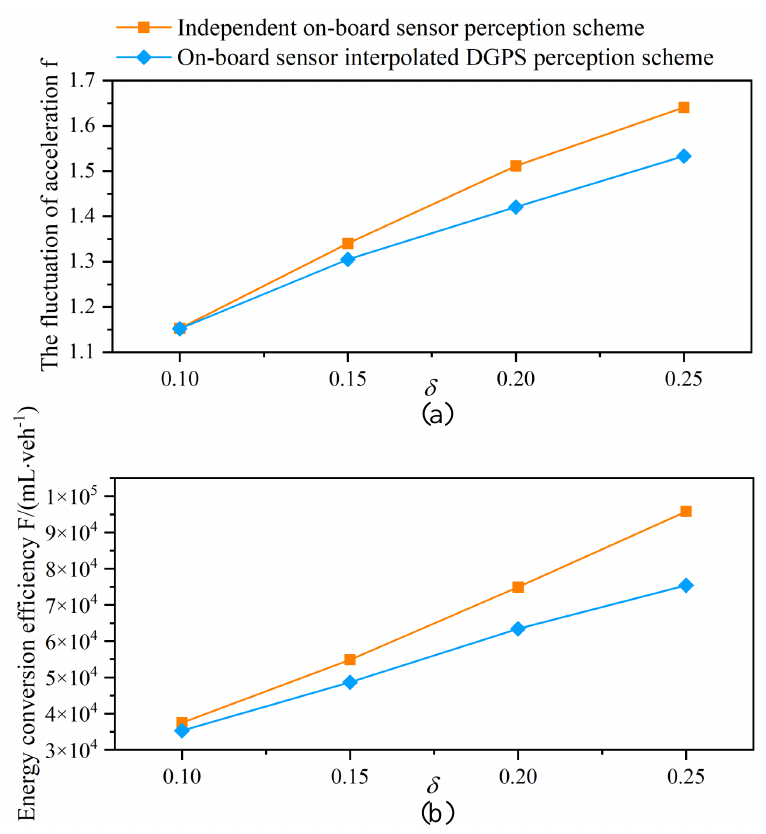
Figure 7. The fluctuation of vehicle acceleration ( a ) and the energy conversion efficiency ( b ) for varying perceptual error size δ with an independent on-board sensor perception scheme and an on-board sensor interpolated DGPS perception scheme in a completely CAV